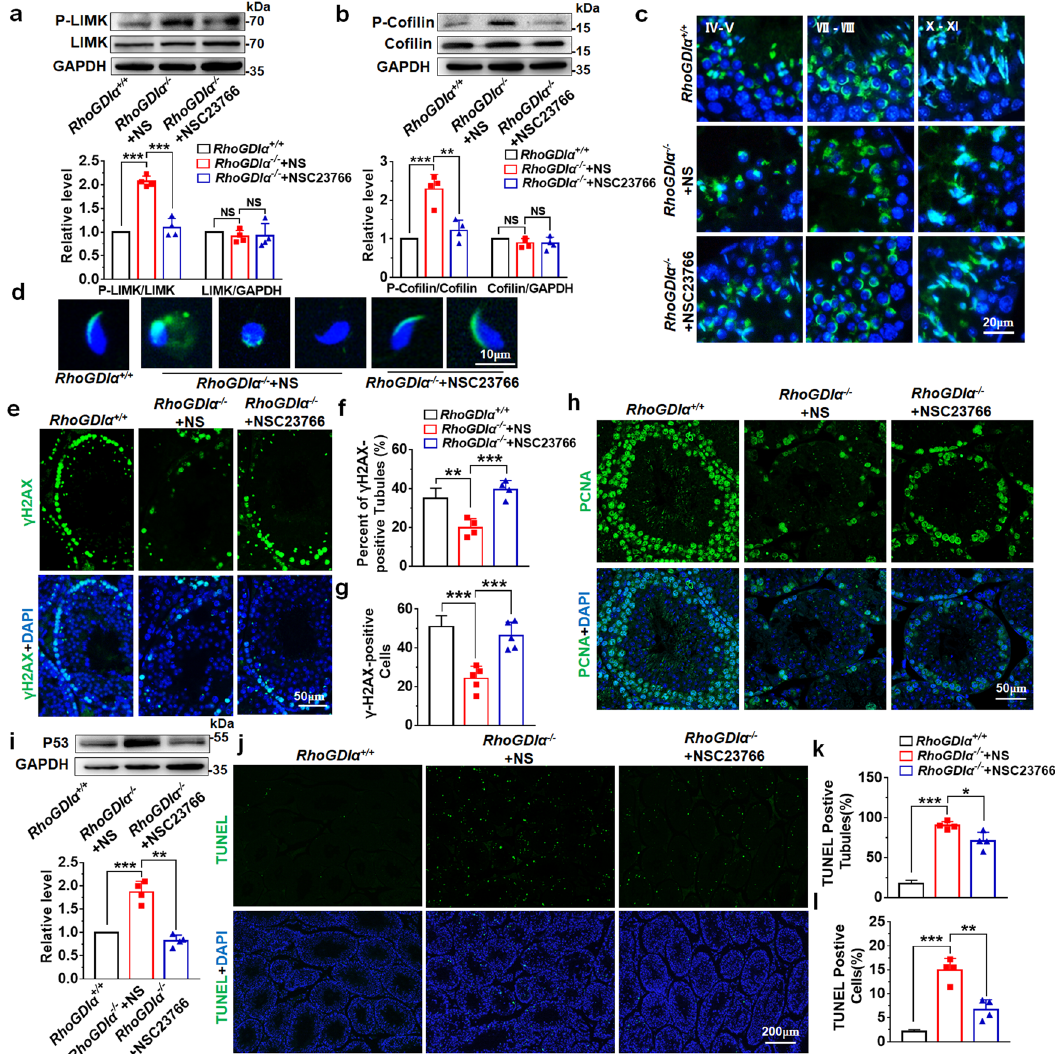
Fig. 9 NSC23766 ameliorated testis injury in RhoGDI α − / − mice. a After NSC23766 treatment of 8-week-old RhoGDI α − / − mice for 4 weeks, LIMK and its phosphorylation levels were detected by Western blot analysis. b Levels of P-co fi lin and co fi lin of testis were also tested in RhoGDI α + / + mice, RhoGDI α − / − + NS mice, and RhoGDI α − / − + NSC23766 mice. a , b n = 4 biologically independent animals. c Acrosomes were tested in the RhoGDI α − / − mouse testes after administration of NSC23766. Scale bar = 20 μ m. d FITC-labeled PNA was used to display the acrosomal morphology of sperms. Scale bar = 10 μ